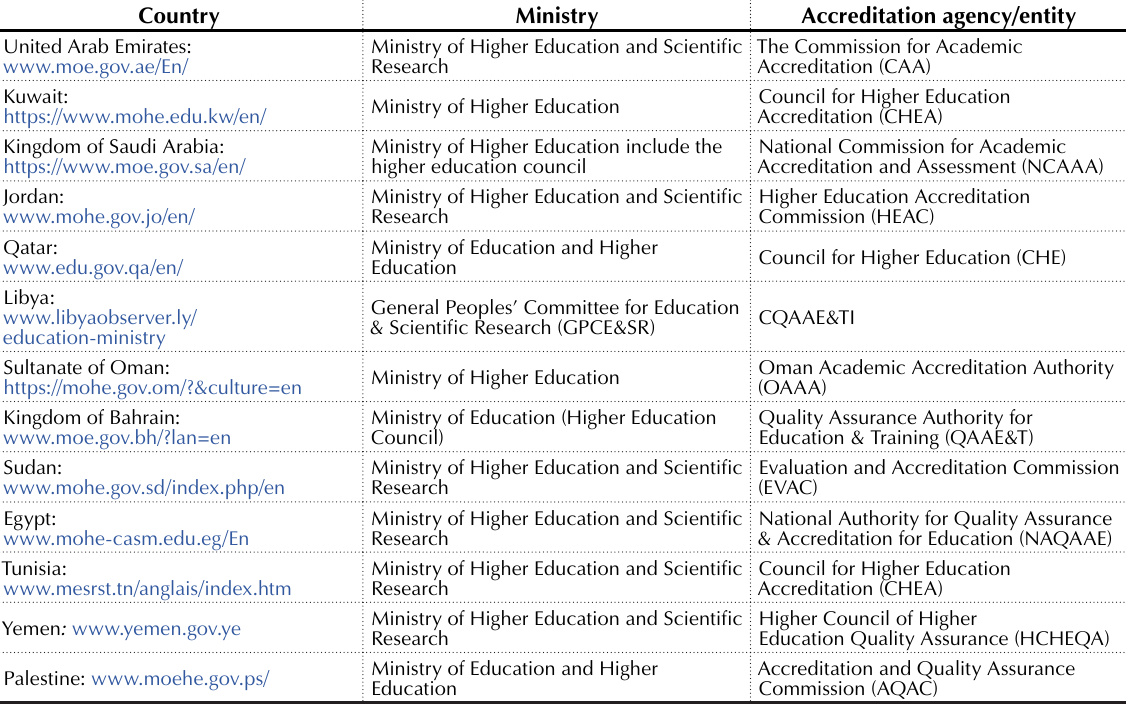
Table 1. Ministries of higher education and accreditation